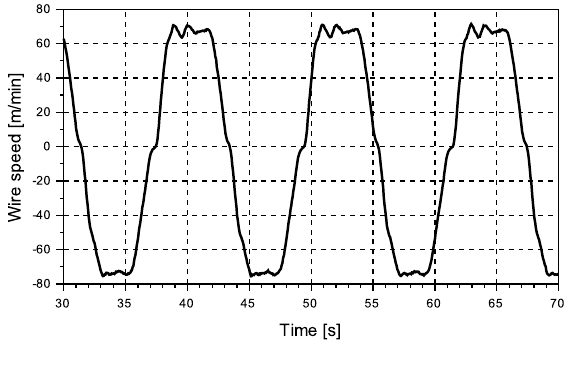
Figure 22: Winch speed profile for Fig. 23 Results are shown in Fig. 23 show about the same or better accuracy as the results with 215 cm 3 / rev, with a pressure deviation of ± 10 bar at the areas constant velocity (low-pressure disturbance by load dynamics).